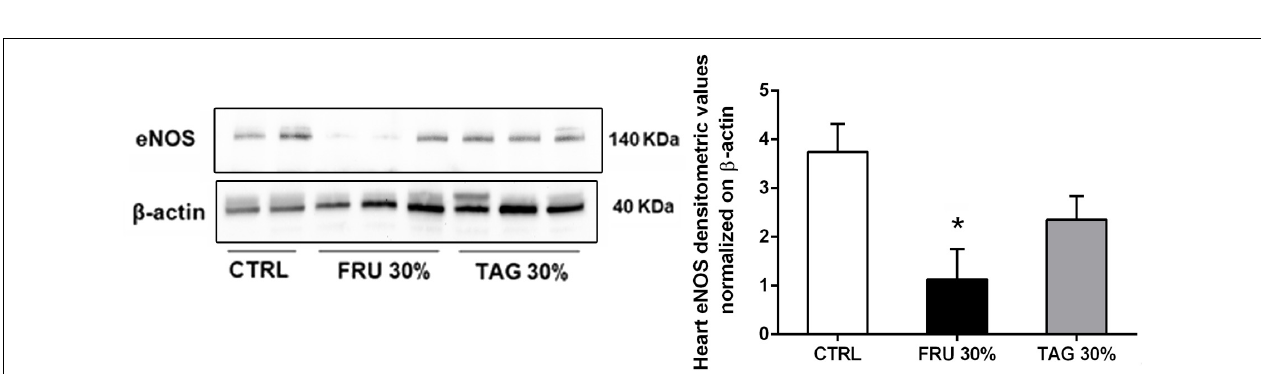
FIGURE 8 | Effects of sugar feeding on cardiac expression of endothelial nitric oxide synthase (eNOS). Representative immunoblots and relative densitometric analysis of the expression of eNOS in heart samples of rats fed with CTRL, FRU 30% or TAG 30%. Densitometric data are reported as relative optical density (OD), corrected for the corresponding β -actin contents. Data are means ± SD for 8 (CTRL and TAG 30%) and 7 (FRU 30%) animals per group; * p < 0.05 vs. CTRL.